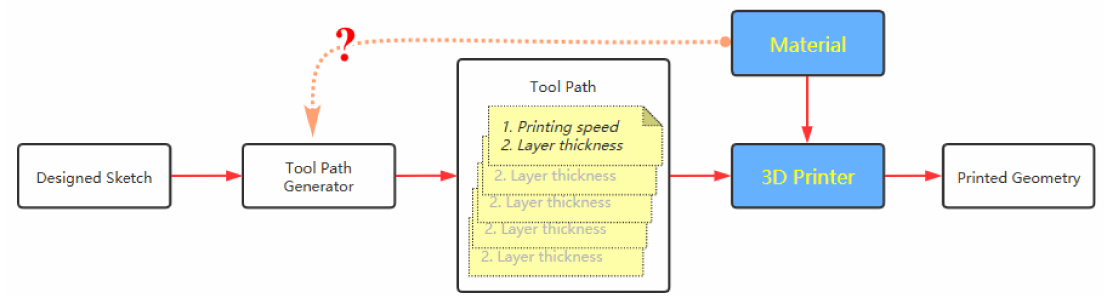
Figure 1. A typical concrete printing procedure lacks configurations from the printing